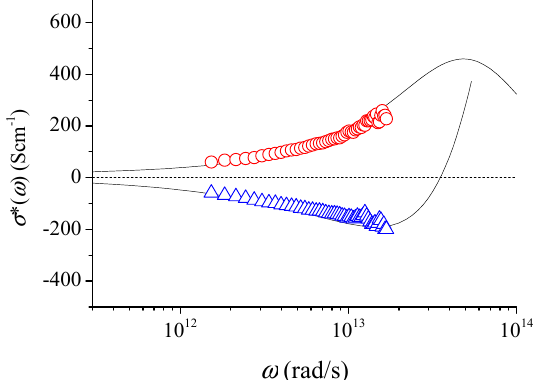
Figure 4. Complex conductivity in crystalline phase of Ge 2 Sb 2 Te 5 films. Open circles and triangles are experimental results of the real and imaginary parts of conductivity, respectively. Solid lines are conductivity predicted from the SSFTC model.